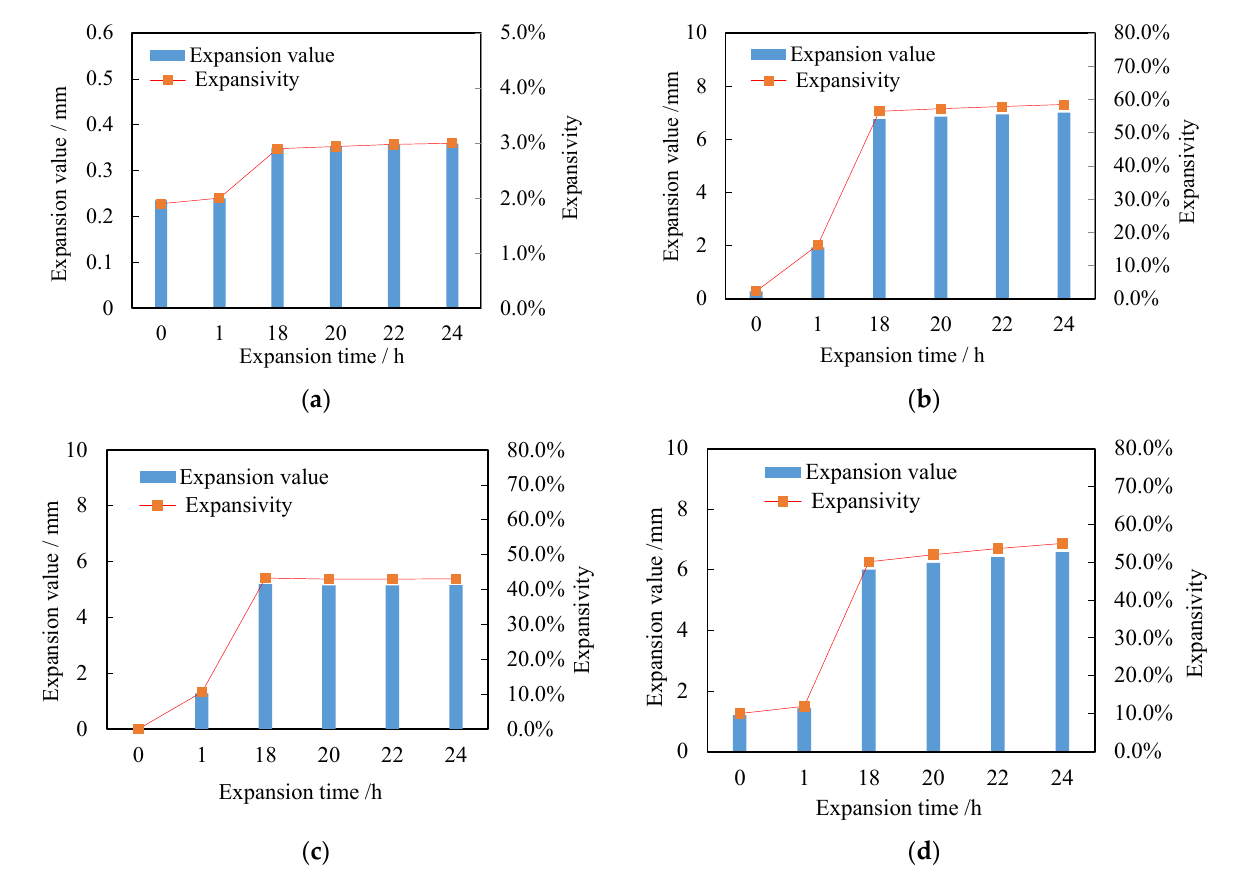
Figure 1. Expansion rate test results. ( a ) Oil-based drilling fluid (density 0.94 g/cm 3 ); ( b ) 10% KCl solution; ( c ) 25% CaCl 2 ; ( d ) purified water.